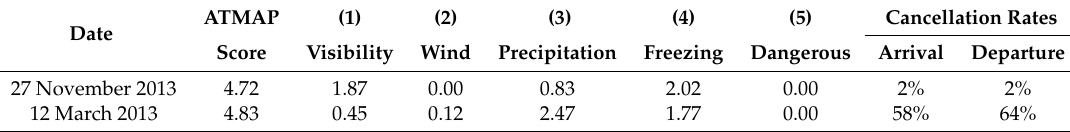
Table 5. Comparison of two exemplary days with approx. similar ATMAP weather scores.